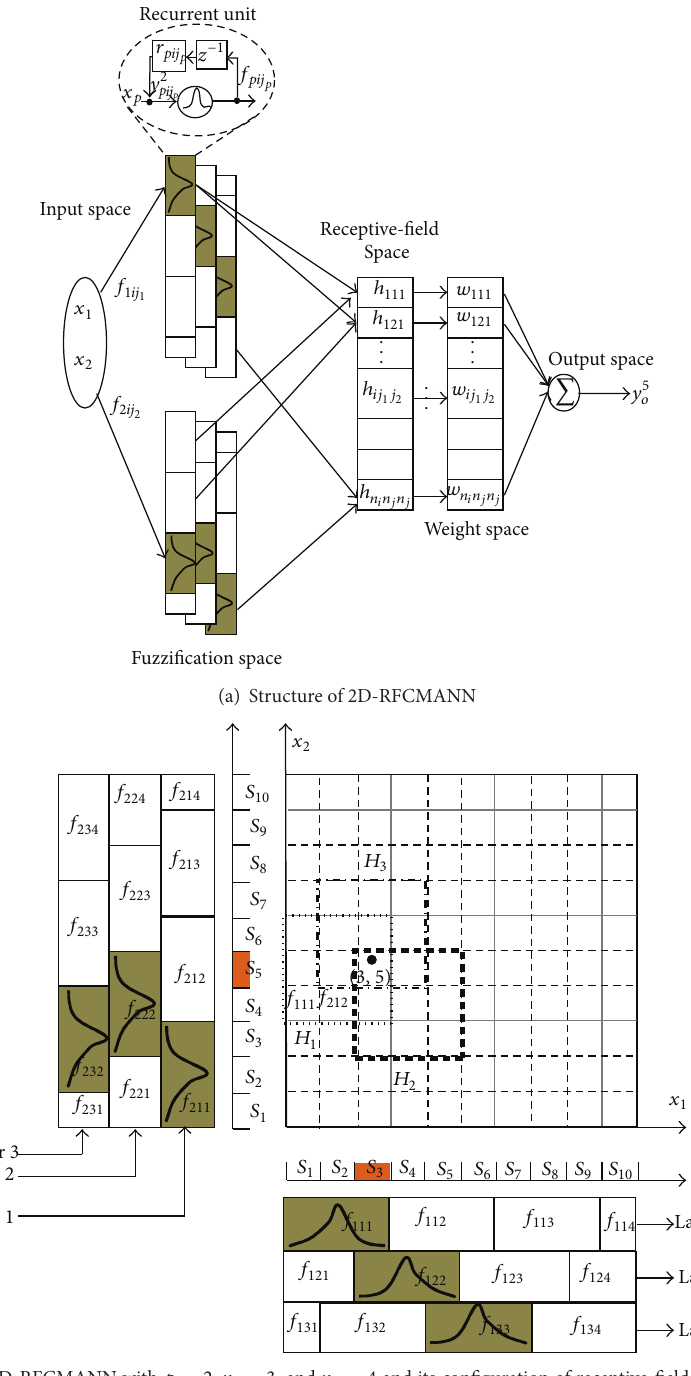
Figure 3: Two-dimensional